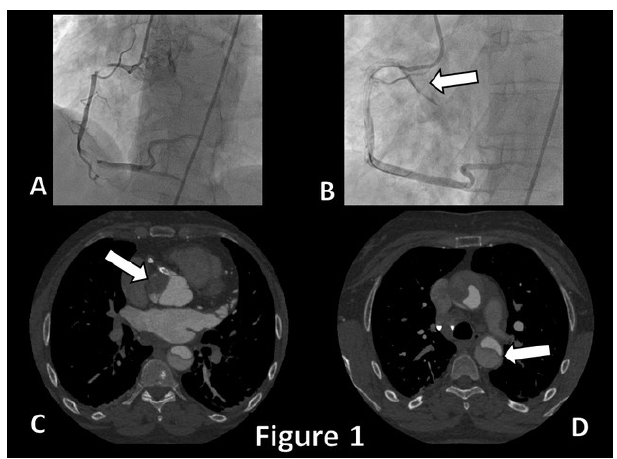
Fig. 1 - Coronary angiogram showing multiple stenosis on the right coronary artery and the evidence of aortic wall dissection after stenting (A & B, arrow). Axial thoracic computed tomography view showing the type A aortic dissection progressing to the descending aorta (C & D, arrows).